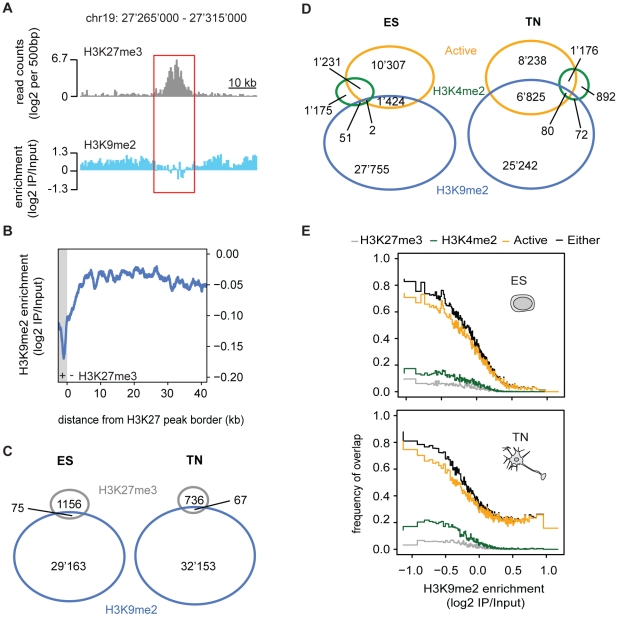
H3K9me2 occurs mutually exclusive with expression and distinct
chromatin marks.(A) Enrichment for H3K27me3 and H3K9me2 in a representative region. (B)
H3K9me2 enrichments relative to peaks of H3K27me3 illustrating the sharp
boundaries between both marks. Plotted are the moving-window averages
(median) of H3K9me2 enrichments with window sizes of 500 bp (blue line)
around all H3K27me3 domains on chromosome 19 (shown in grey). (C) and
(D) Venn diagram illustrating the actual overlap between H3K9me2 and
H3K27me3 occupied regions (C) and between H3K9me2, H3K4me2 occupied and
active regions (D). Numbers indicate base pair coverage on chromosome 19
(in kb). Note that areas are not drawn to scale. (E) The higher H3K9me2,
the less likely a genomic region is active or contains H3K27me3 or
H3K4me2. H3K9me2 enrichment values of 500 bp windows were binned into
groups of equal size. Plotted is the frequency for H3K9me2 enrichment
bins to overlap with active regions (orange), H3K27me3 occupied (gray),
H3K4me2 occupied (green) and regions in either of these states
(black).